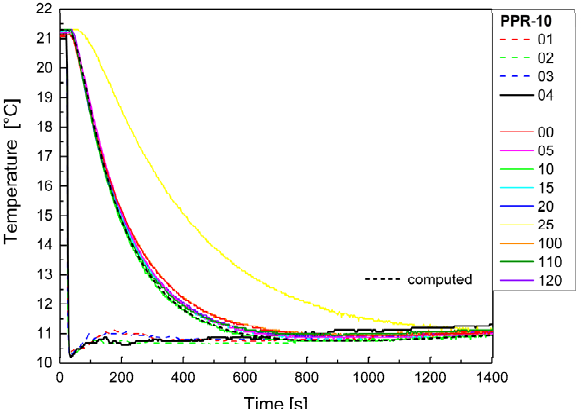
Figure 15. Time-history of measured temperatures and the temperatures computed in the probe axis (measurement A—water bath temperature of 10 °C/probe 1).